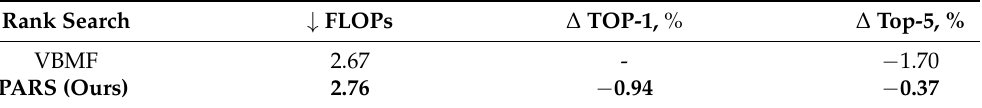
Table 5. Evaluation of PARS in the multi-rank case of AlexNet on the ILSVRC-2012 dataset. Rank Search FLOPs ∆ TOP-1, % ∆ Top-5, % ↓ VBMF